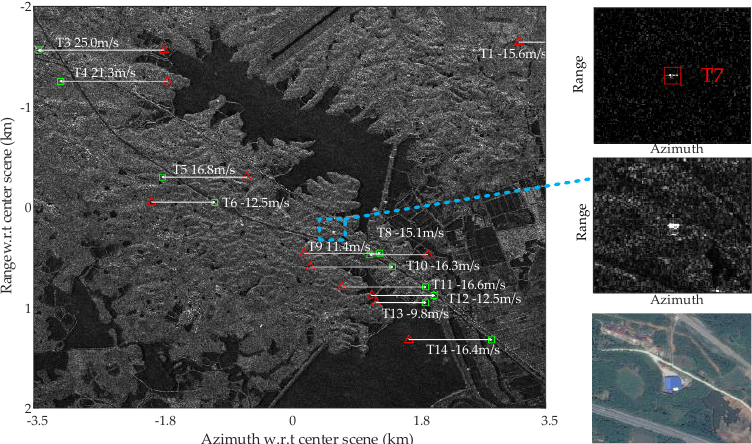
Figure 12. Relocation map of the moving targets with ground radial velocities estimated by adaptive matched filter (AMF) (upper chip is the SSP output of Target 7, middle chip is the magnified SAR image containing Target 7, and lower chip is the optical image corresponding to the middle chip).